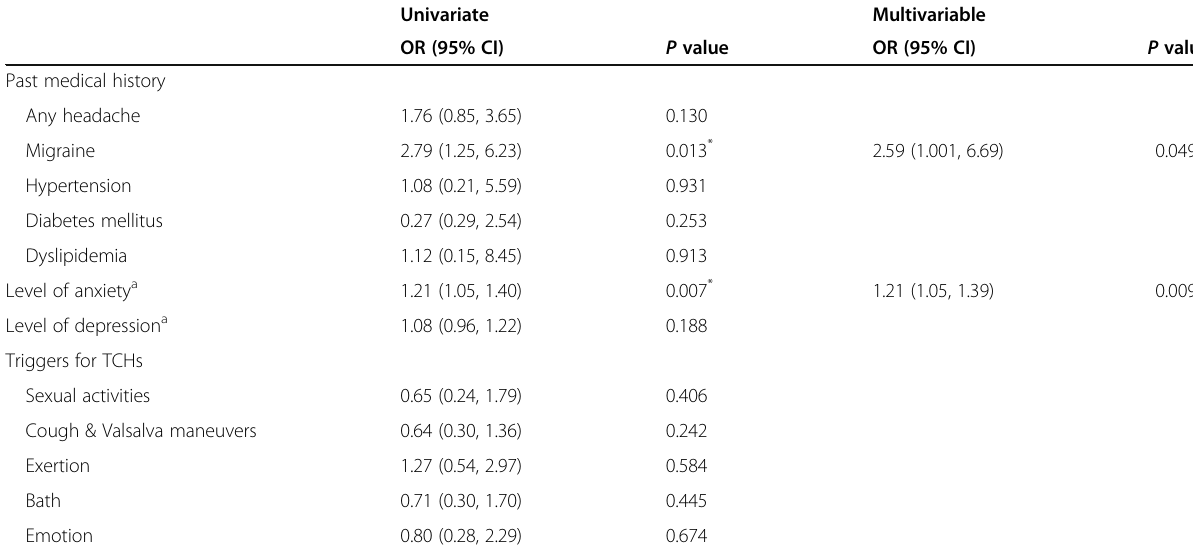
Table 3 Factors associated with post-RCVS headache